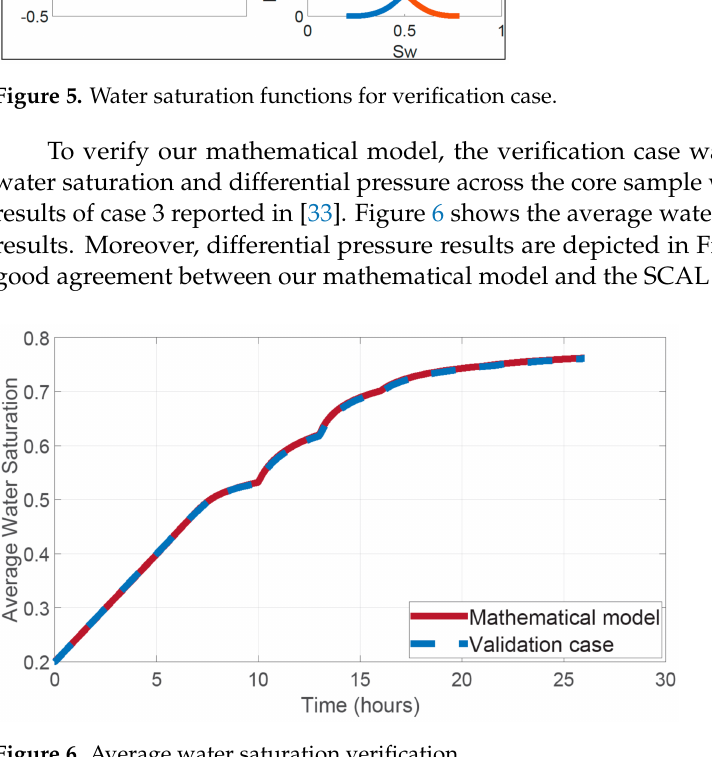
Figure 6. Average water saturation verification.